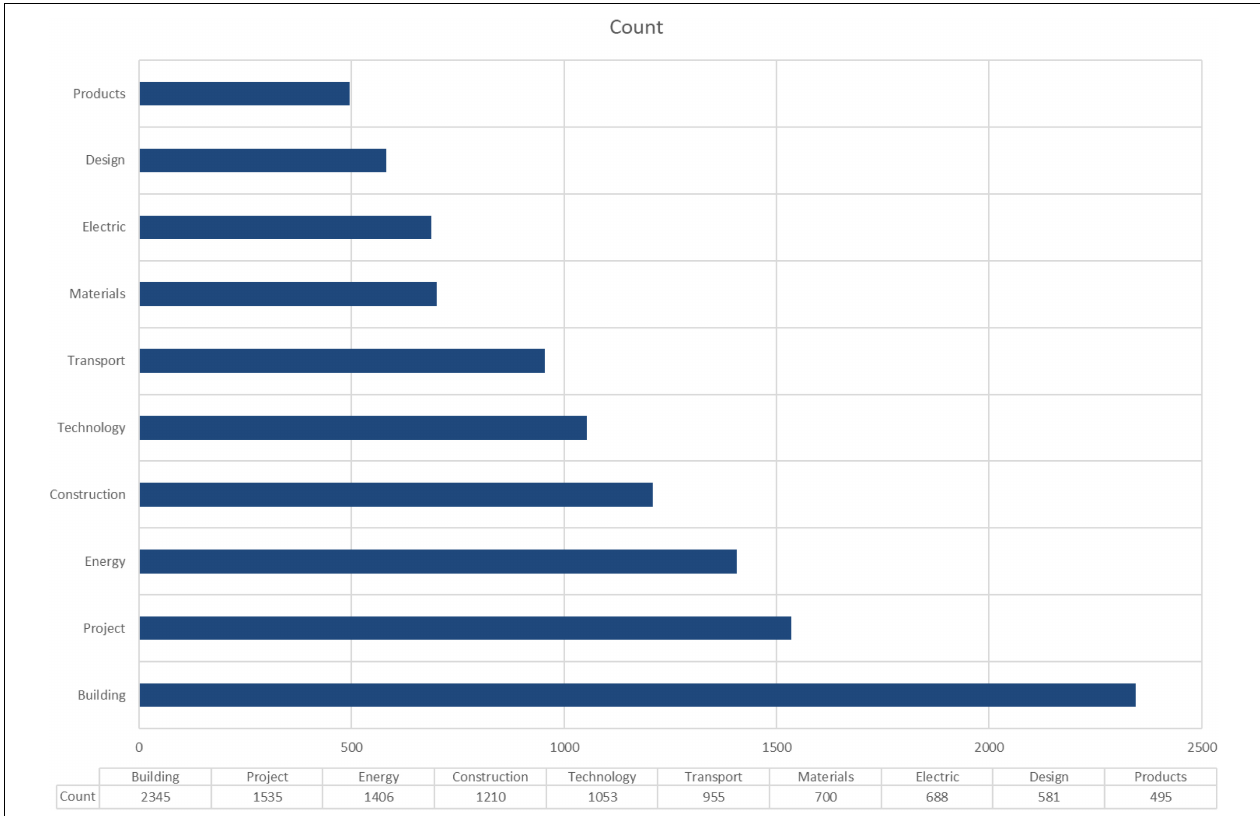
FIGURE 3 | Number of citations in student portfolios of construction